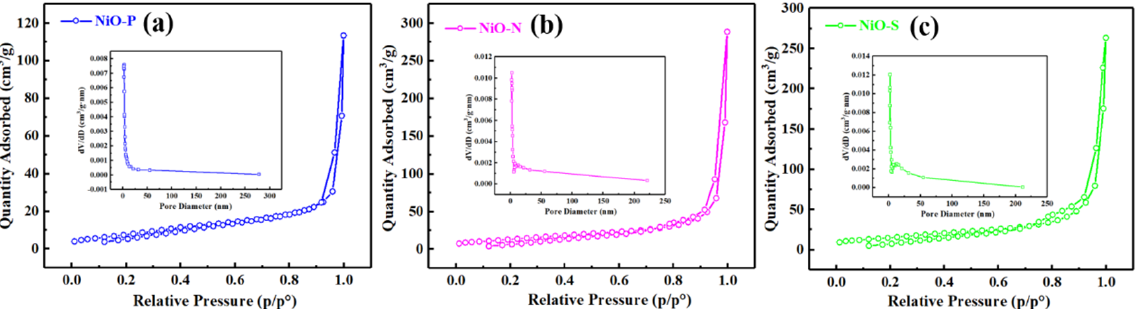
Figure 7. N 2 adsorption and desorption isotherms and pore-size distribution curves (insert) of ( a )